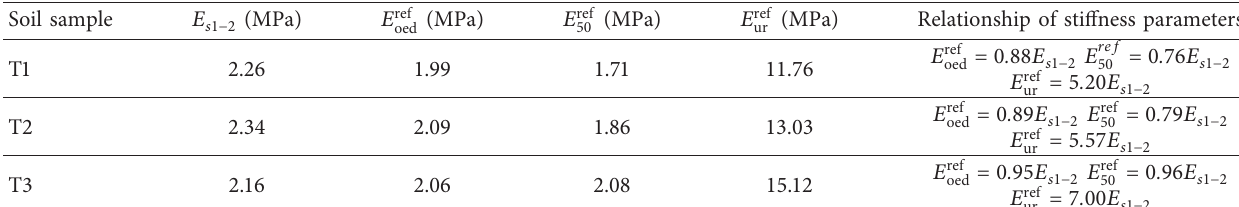
Table 5: Relationship of stiffness parameters of soil